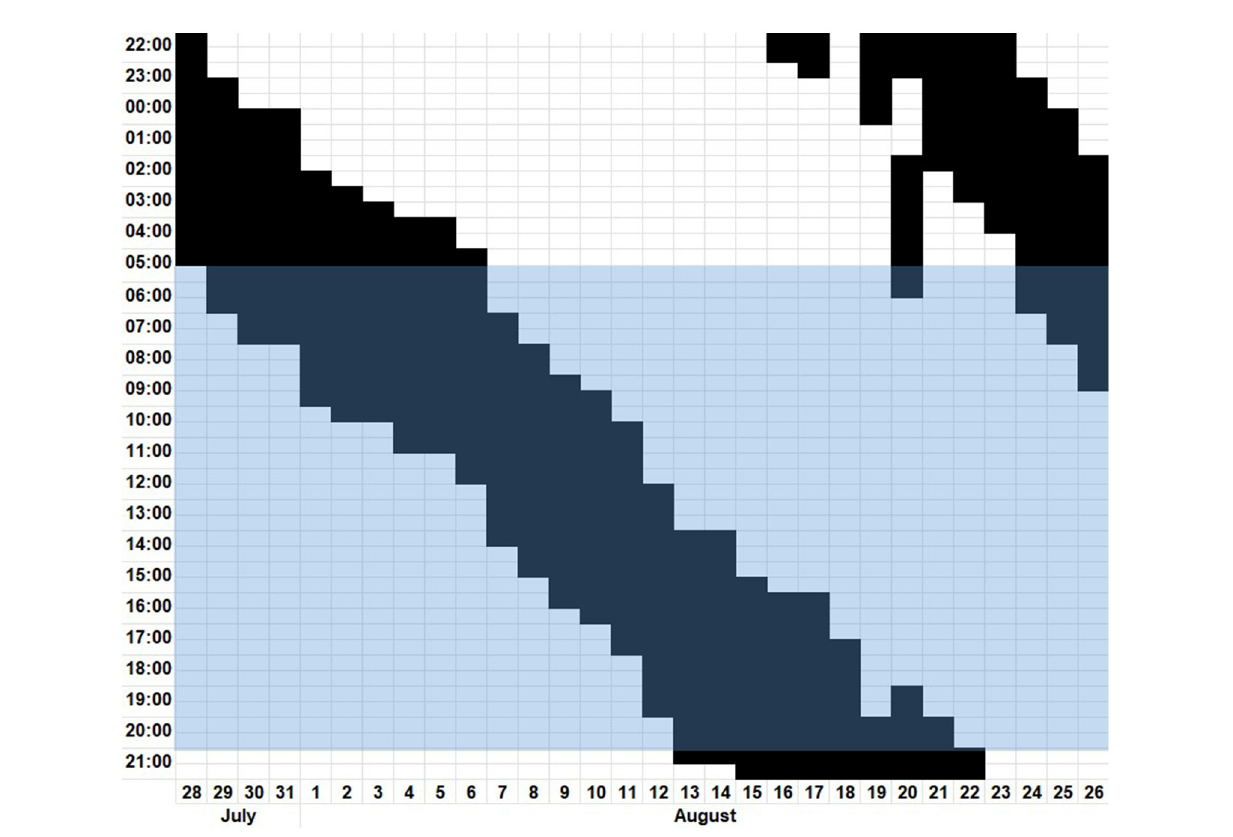
FIGURE1 Digitalized patient’s sleep diary from 28th July to 26th August depicting the time slept in black and the time awake in white. The blue highlighted block represents the time from sunrise to